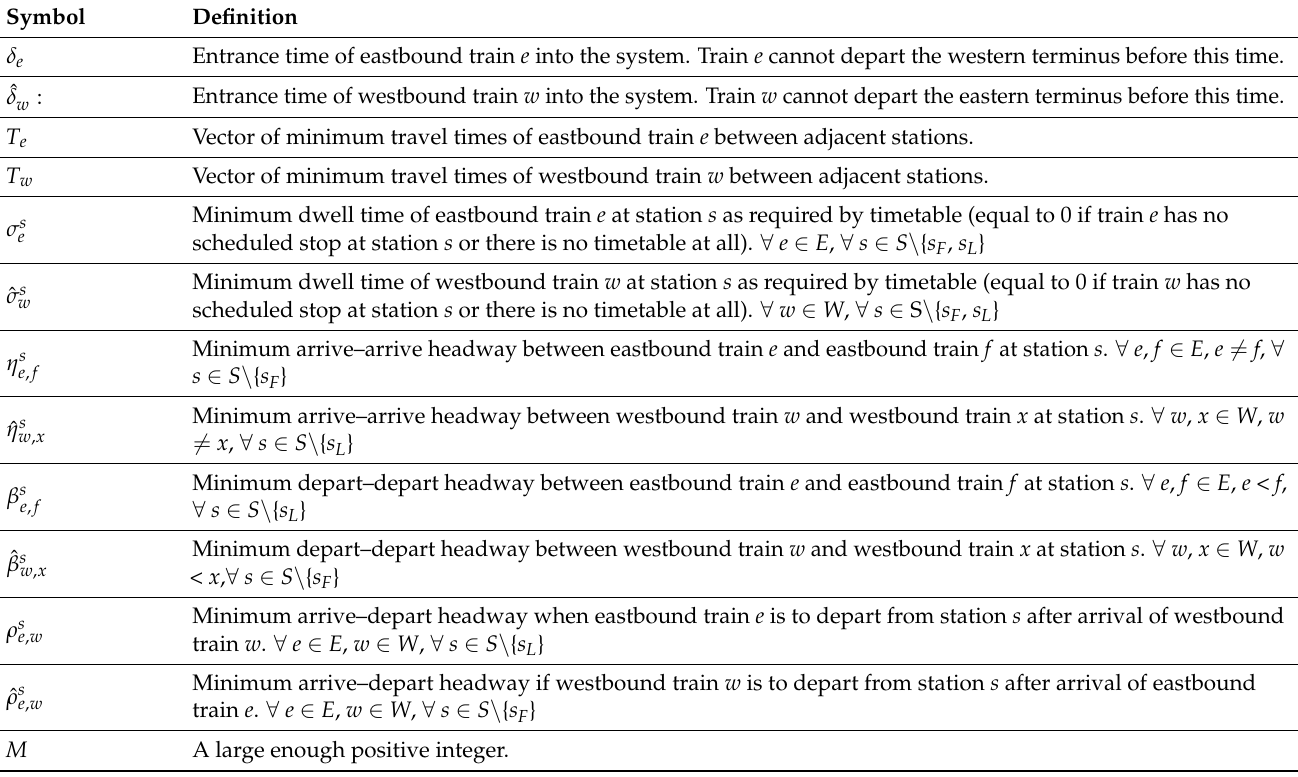
Table 3. Parameters and objective